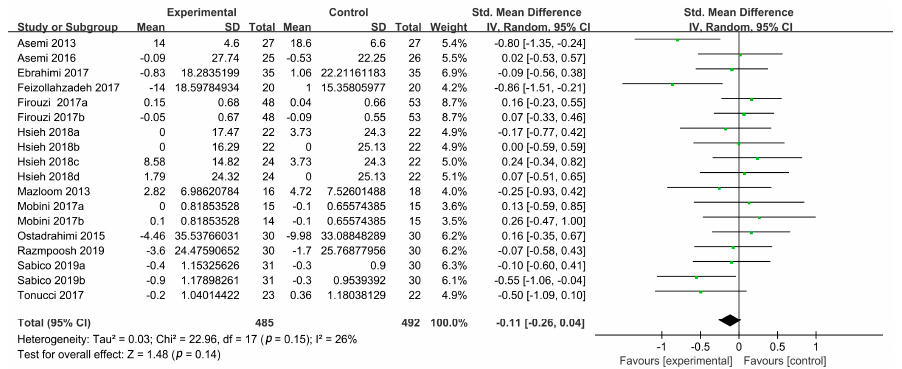
Figure 5. Forest plot of the effects of probiotics on LDL-C concentrations.